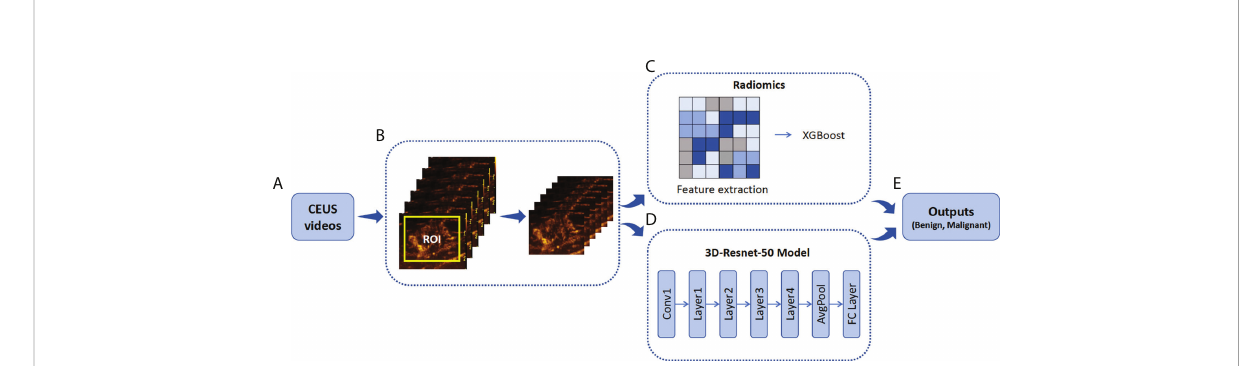
FIGURE 2 Illustration of ROI annotation in CEUS videos and the design of Radiomics and 3D-Resnet-50 models. (A) CEUS examinations were performed for each breast tumor. (B) An example of the yellow bounding box ROI drawn in one CEUS frame. (C) Schematic of radiomics combined with the XGBoost model. (D) A three-dimensional ROI (2D in space and 1D in time) of CEUS videos was fed into the 3D-Resnet-50 model to obtain the discriminative features by automatic feature learning. (E) The features obtained from the radiomics and 3D-Resnet-50 models are used to calculate the prediction probability. ROI, region of interest; CEUS, contrast-enhanced ultrasound; ResNet, residual